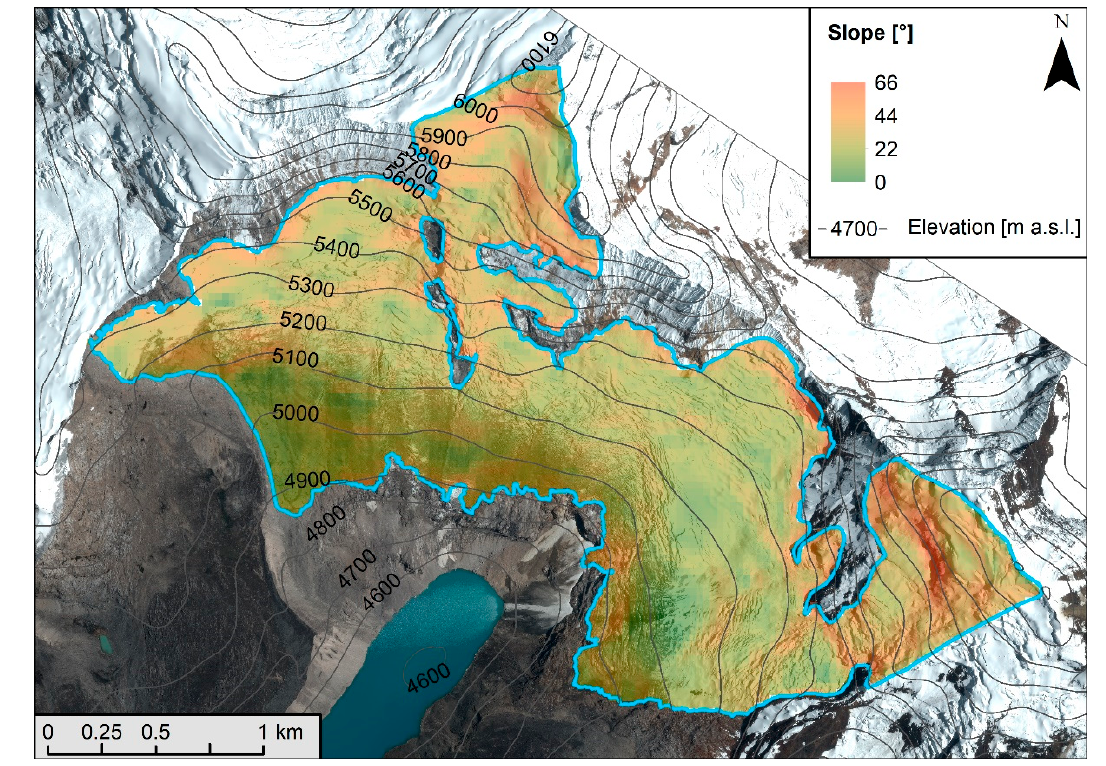
Remote Sens. 2021 , 13 , x FOR PEER REVIEW